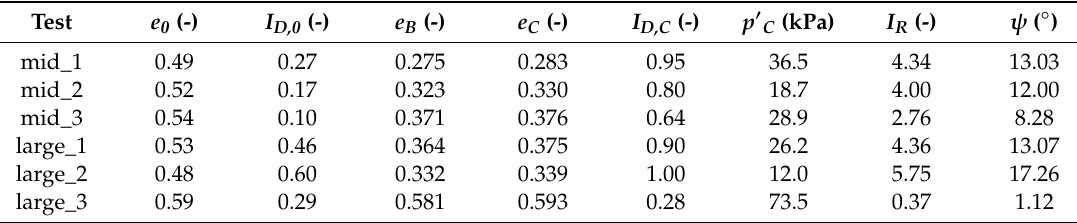
Table 7. Calculated dilatancy in triaxial